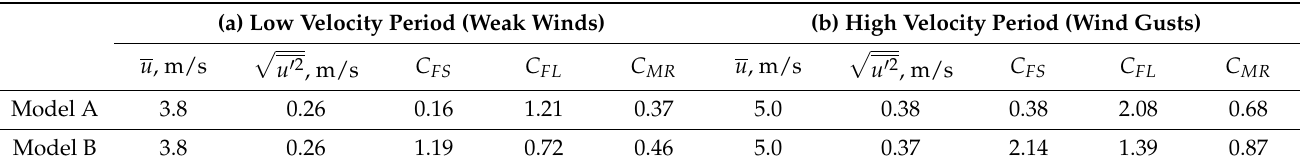
Table 1; u is average freestream flow velocity. C FS , C FL and C MR coefficients are calcu- lated using the same velocity u averaged during low wind periods of the time record ( u = 3.8 m/s). Table 1. Steady aerodynamic side force, lift force and overturning moment